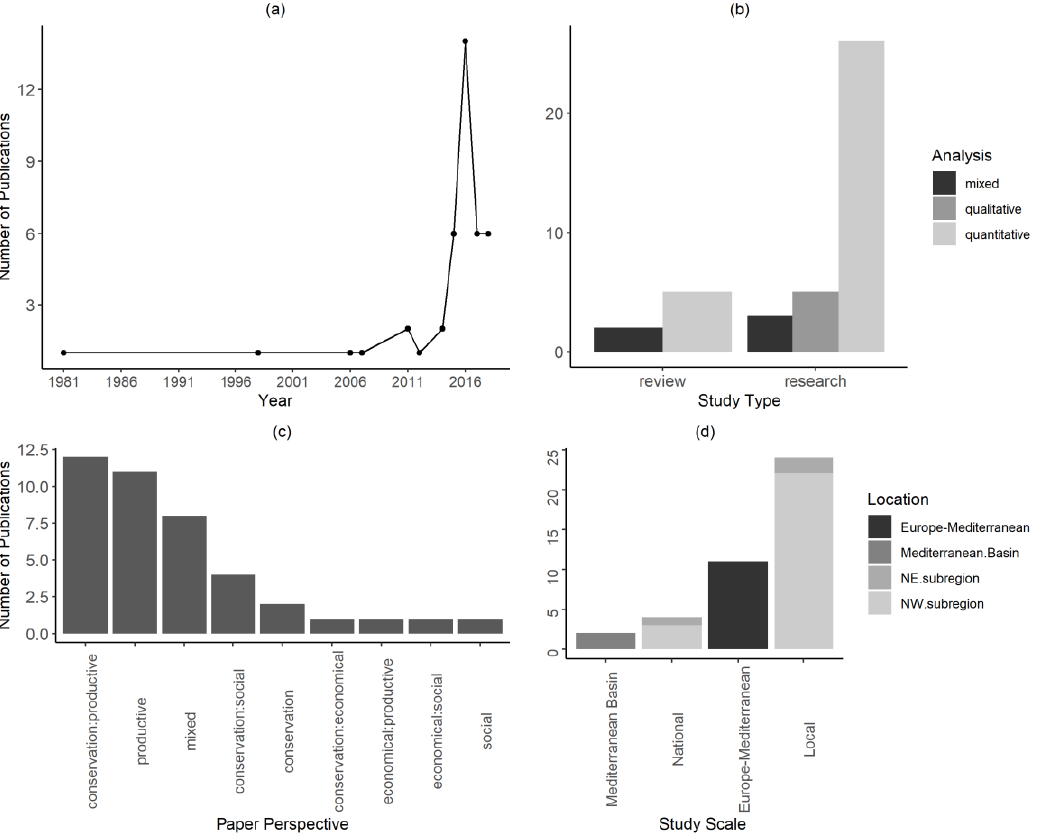
Figure 2. A descriptive analysis of the selected 41 studies on Mediterranean agroecosystem services. ( a ) Number of publications per year. ( b ) Number of studies according to the type of analysis. ( c ) Number of studies according to the paper focus (productive, economic, social, conservation, mixed (when 3 categories or more could be assigned to the paper)). ( d ) Number of studies according to the location and the scale of the study.